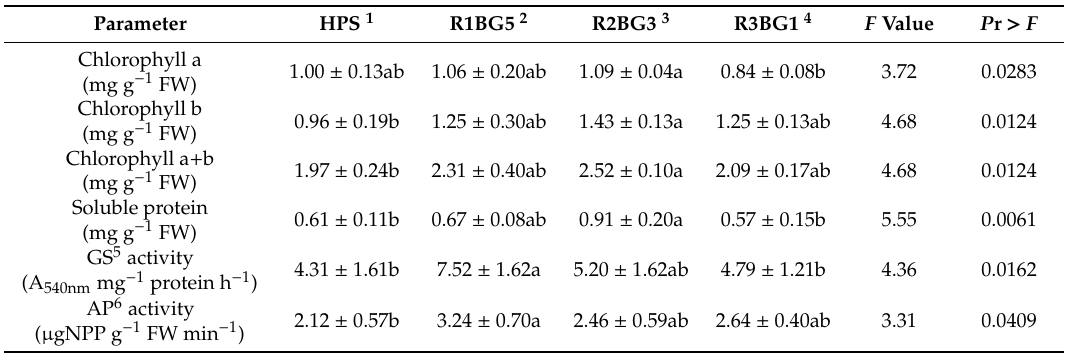
Table 3. Physiological responses of the contents of chlorophyll and soluble protein and activities of glutamine synthetase (GS) and acid phosphatase (AP) in the needles of Korean pine ( Pinus koraiensis ) seedlings exposed to four regimes of artificial lighting spectra.